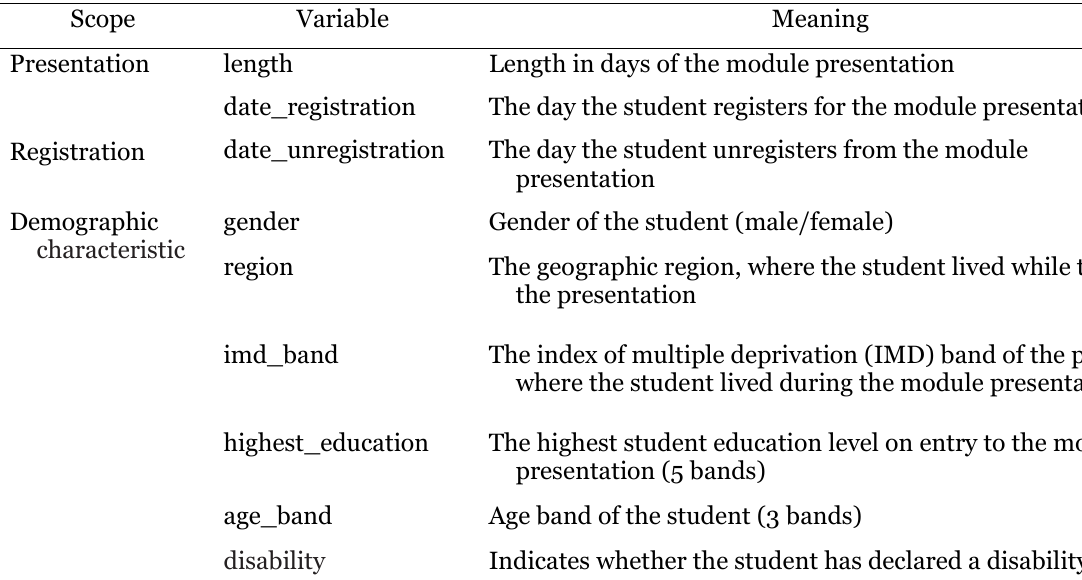
Characteristics in the OU Dataset Linked to the Research